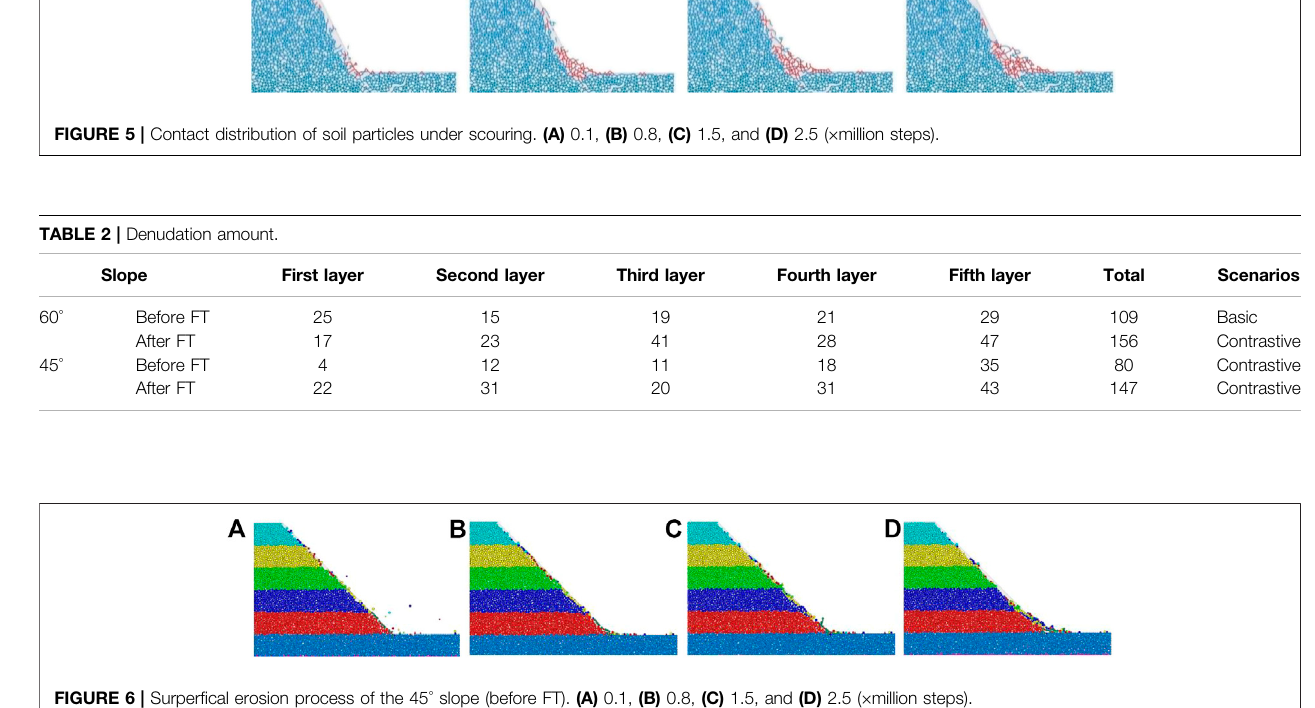
Frontiers in Materials |